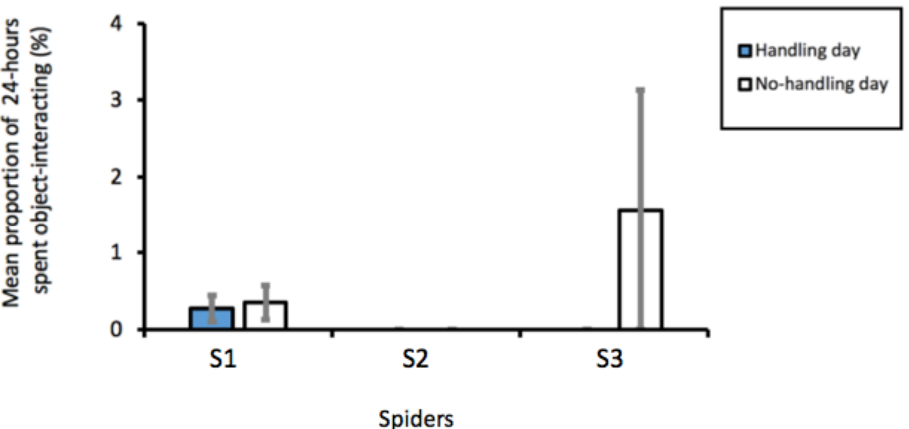
Figure 4. Mean ± SE percentage (%) of handling days (H) and no-handling days (NH) that S1 (8H, 6NH), S2 (6H, 8NH) and S3 (4H, 2NH) spent exhibiting object-interaction behaviour.